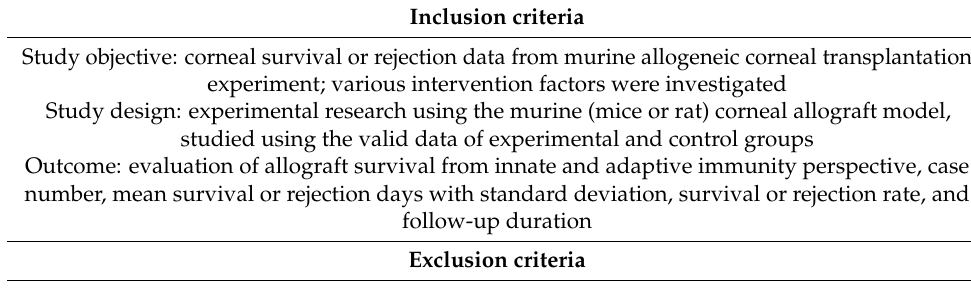
Table 1. Inclusion and exclusion criteria for